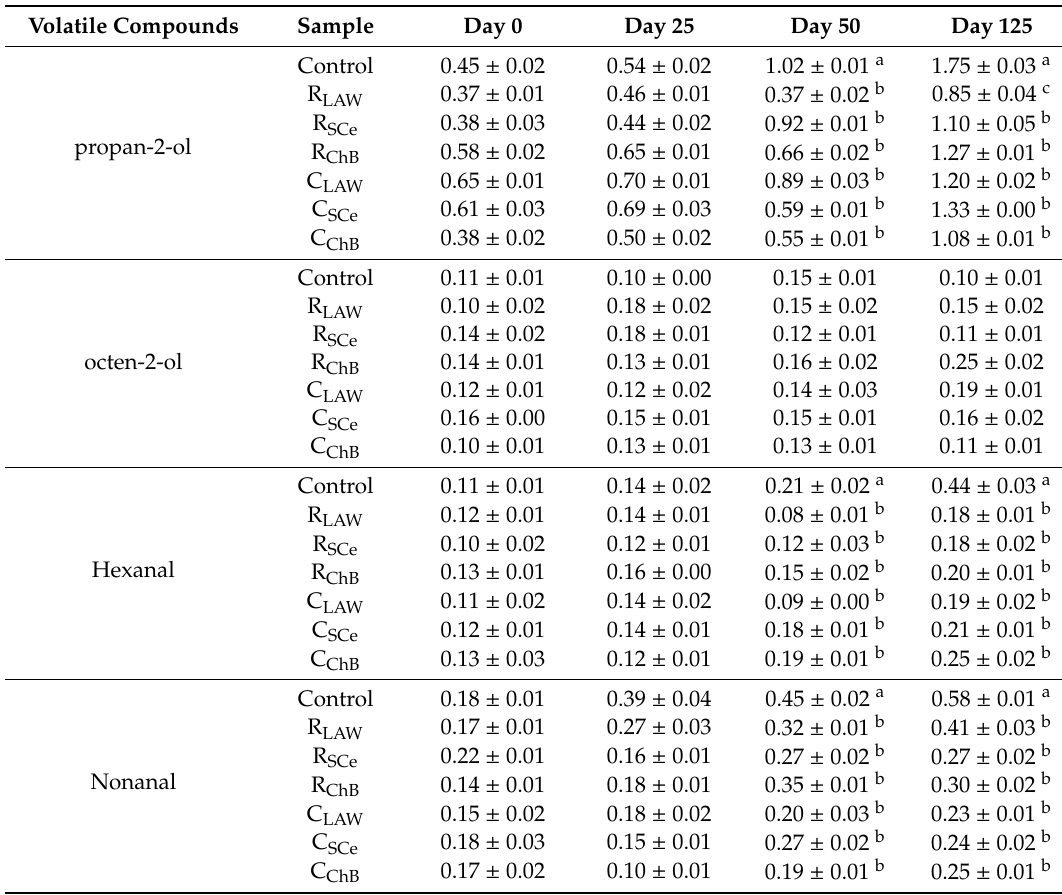
Table 4. Average values and standard deviations of volatile compounds (mg / g meat) in chorizo stored for 0, 25, 50, and 125 days, under retail